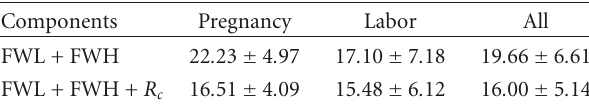
Figure 4: Example of a labor contraction (a), the corresponding scalogram (b) and the extracted ridges corresponding to FWL and FWL (c). Table 2: Reconstruction error (NPMSE, %) obtained using only the sum of FWL and FWH or by using the sum of FWL, FWH and R c (complementary ridge) for pregnancy, labor or all contractions.